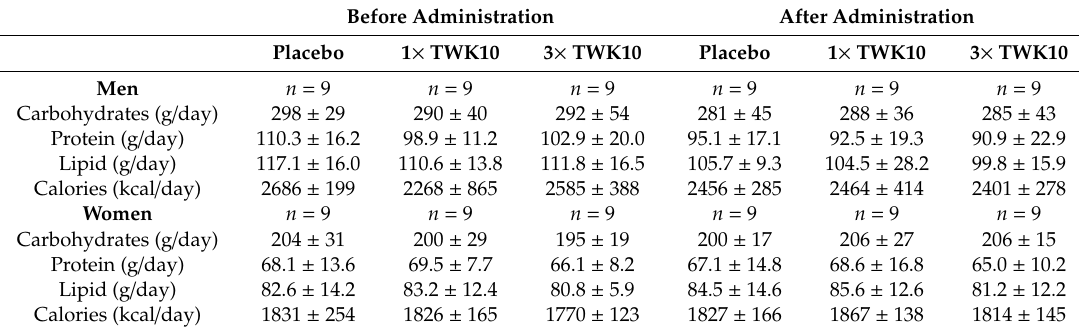
Table 3. Dietary information of